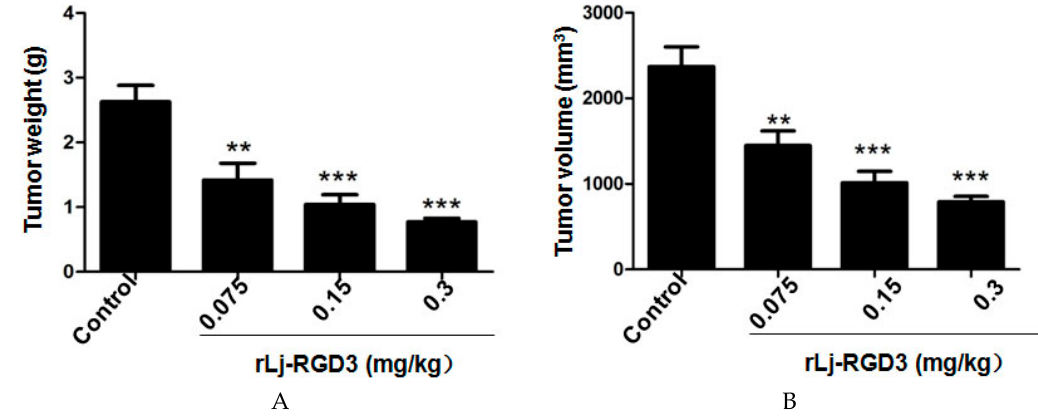
Figure 3. rLj-RGD3 suppressed the weight ( A ) and volume ( B ) of the solid tumors in HeyA8 xenografted mice ( n = 8). Relative to the control group: ** p < 0.01; *** p < 0.001.